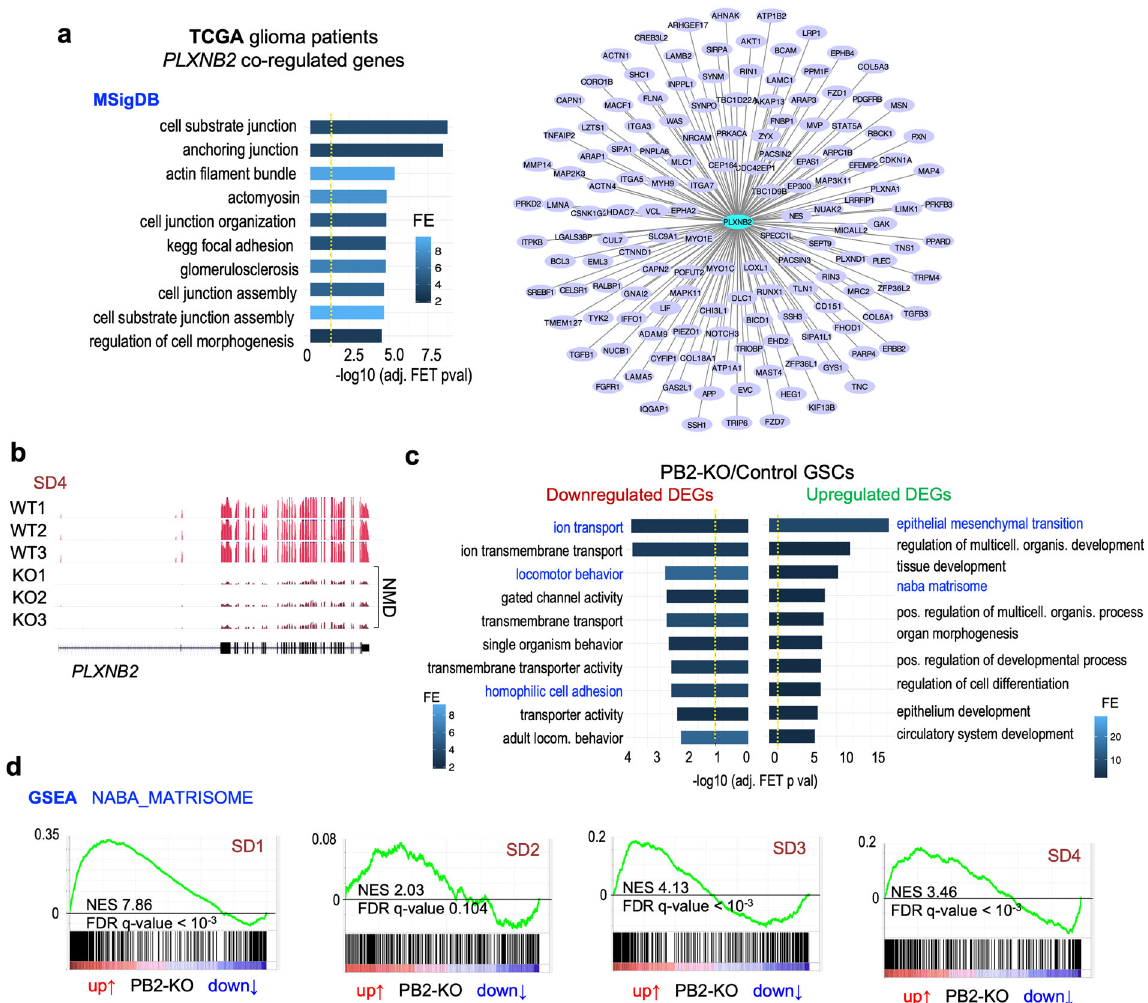
Fig. 6 Gene expression analyses link Plexin-B2 to biomechanical gene signatures in GBM. a Genes that are correlated with PLXNB2 expression levels in GBM patients (Spearman correlation FDR < 10%, TCGA database) are enriched for pathways concerning cell adhesion, cell-substrate junctions, and actomyosin. Left, top 10 signi fi cant functional terms (MSigDB) are shown. Right, diagram of connectivity of coregulated genes with PLXNB2 in human GBMs, fi ltered for genes involved in cell adhesion, motility/invasion, and EMT. b Examples of RNA-seq read tracks for PLXNB2 mRNA in three GSC clonal